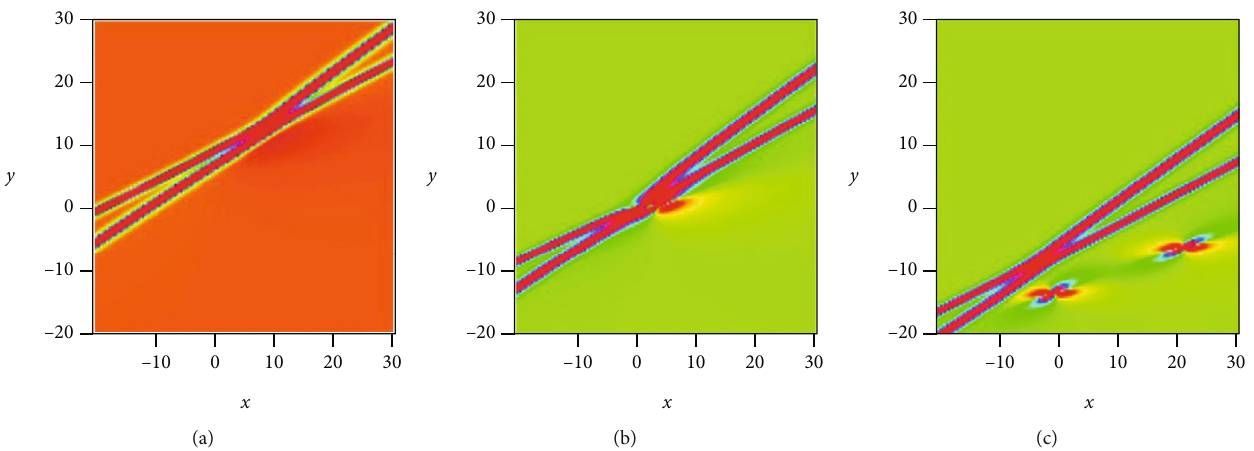
Figure 8: The multiple semirational solution u = 2 ln ð G Þ , where G is given by (36) with p 1 = 1 − i , q 1 = 1 + i , p 2 = 1 − ð 3/4 Þ i , q 2 = 1 + ð 3/4 Þ i xx , a = 1 , b = 1 , τ = 0 , c 11 = 1 , d 11 = 1 , c 21 = 1 + i , d 21 = 1 − i , C 11 = 1 , C 12 = C 21 = 0 , C 22 = 2 , ξ 10 = η 10 = ξ 20 = η 20 = 0 : (a) t = − 2 , (b) t = 0 , and (c) t = 2 peak of lump moves along the trajectory ½ x ð t Þ , y ð t Þ(cid:2) : 1 ′ − ð 42 Þ ξ 2 p R R ′ = x + 2 p − p 2 Þ + 8 b ð 3 p 2 − p 3 Þ(cid:2) t + 12 where ξ y + ½ 12 a ð p 2 p R R I R I I I